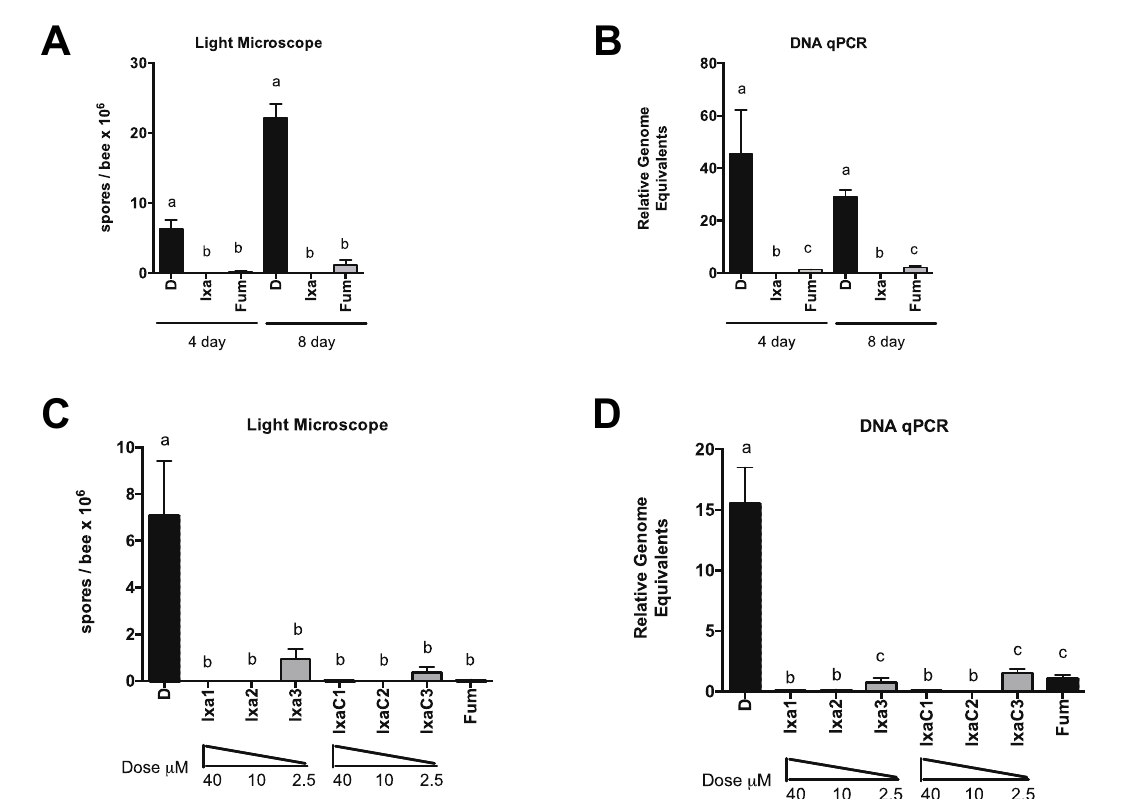
Figure 4. Ixazomib reduces N. ceranae infection level in a dose and time dependent manner in newly eclosed bees. ( A ) N. ceranae levels in midguts of infected newly eclosed bees fed sucrose solution containing DMSO or ixazomib for 4 or 8 days as determined by spore count using light microscopy ( A ) or by qPCR ( B ) a ≠ b, p < 0.05. N. ceranae levels in midguts of infected newly eclosed bees fed sucrose solution containing DMSO or various doses of ixazomib for 4 days as determined by spore count using light microscopy ( C ) or by qPCR ( D ) a ≠ b ≠ c, p < 0.05.